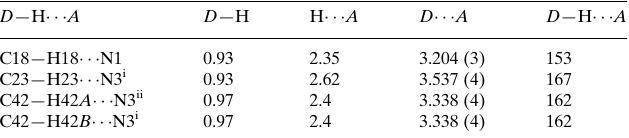
Hydrogen-bond geometry (A˚ , (cid:3)